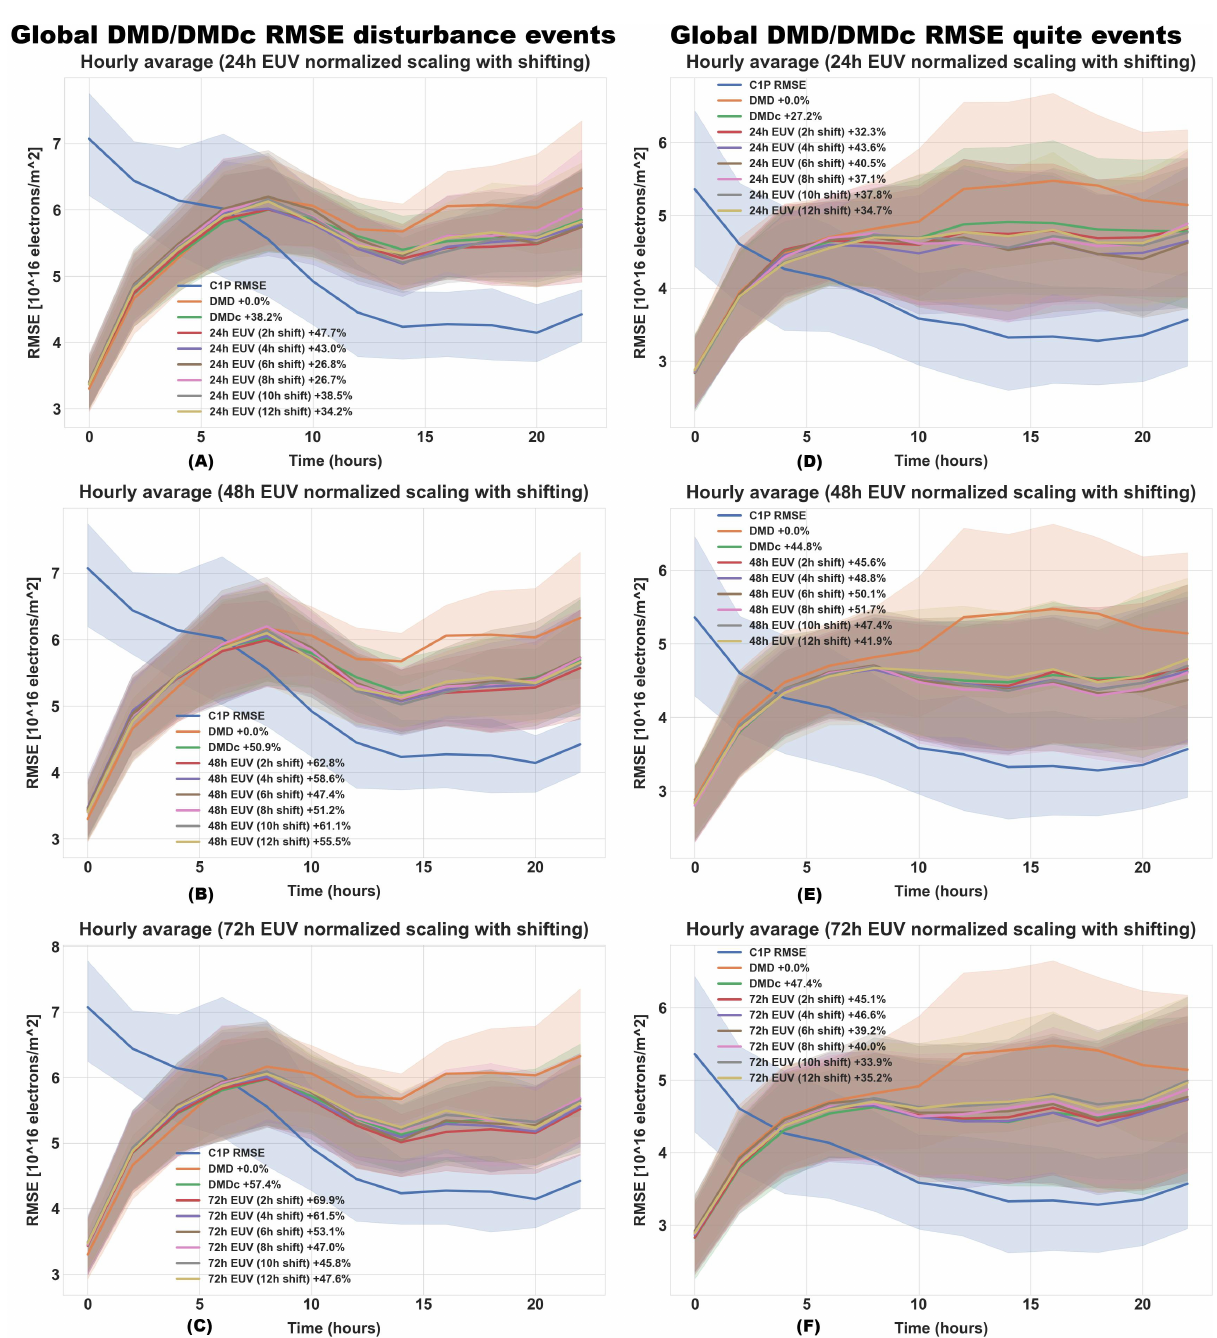
Figure 5. RMSE evaluation plot of the DMD, DMDc, and C1P predictions with the 2-h candidate. On the left side, sub-figure group ( A – C ) present the vTEC RMSE for the disturbed case studies with length parameters: 24, 48, and 72, respectively. On the right side, sub-figure group ( D – F ) present the RMSE for the quiet case studies with length parameters: 24, 48, and 72, respectively. All the sub-figures present the examined shift parameters of the control input signal and its improvement over the DMD model. Note that the DMDc has a zero shift